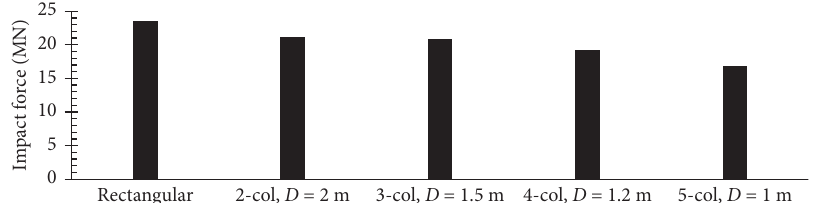
Figure 15: Impacting forces on the first pier of the bridges with different pier systems.